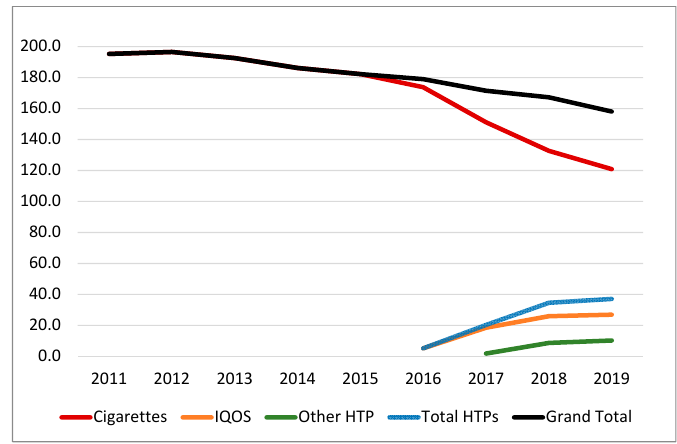
Figure 1. Sales of cigarettes, IQOS, and other HTPs (billion sticks).